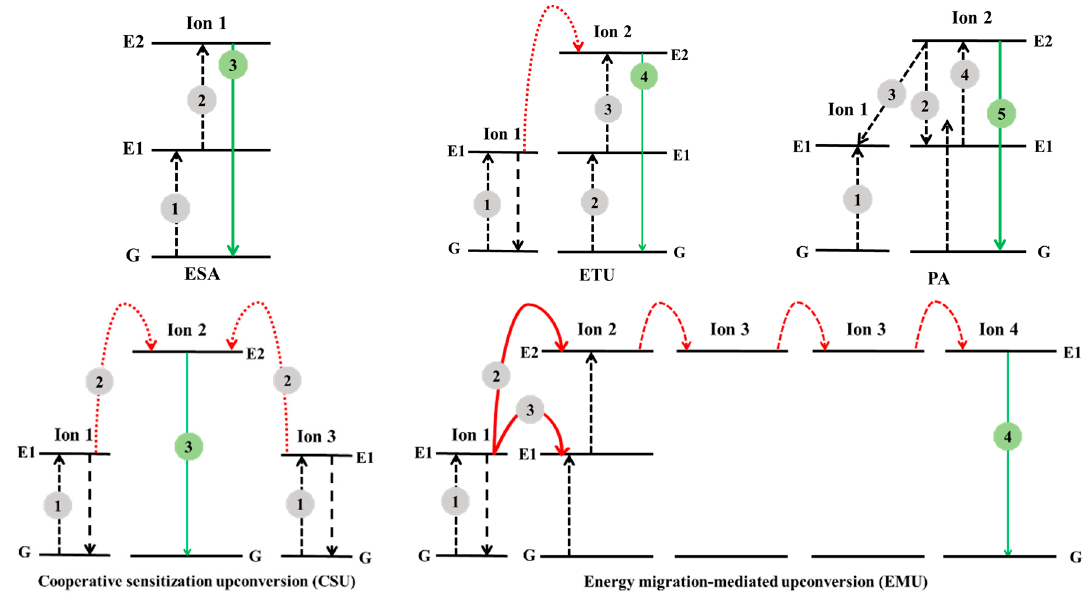
Figure 1. Overview of upconversion mechanisms.